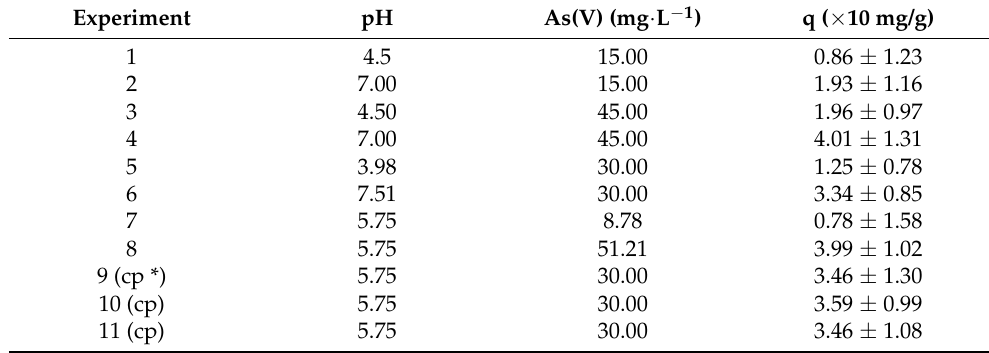
Table 1. Results of the (CCD)2 2 experiment in terms of arsenic adsorbed by the BCXZM composite.